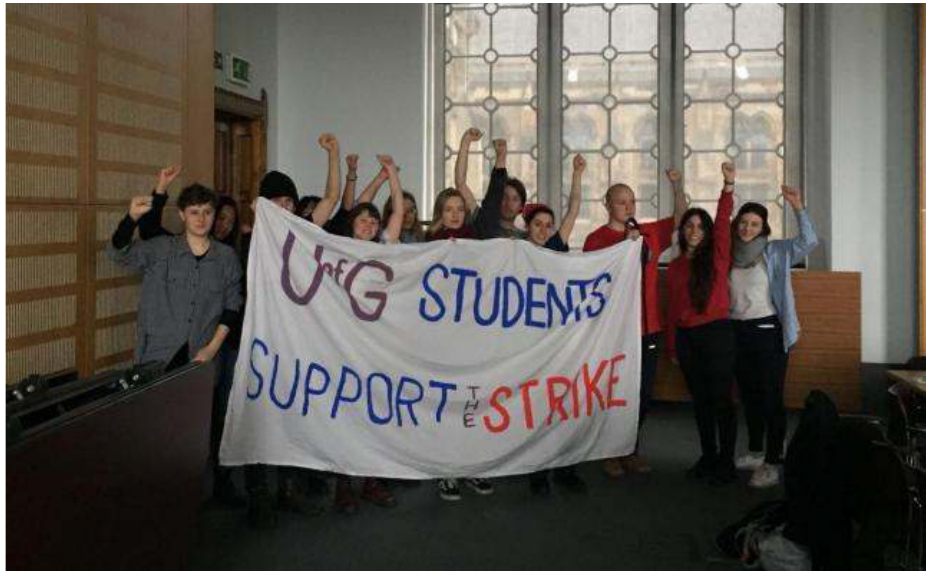
Figure 5. Glasgow University Strike. Solidarity Occupation. March 15, 2018